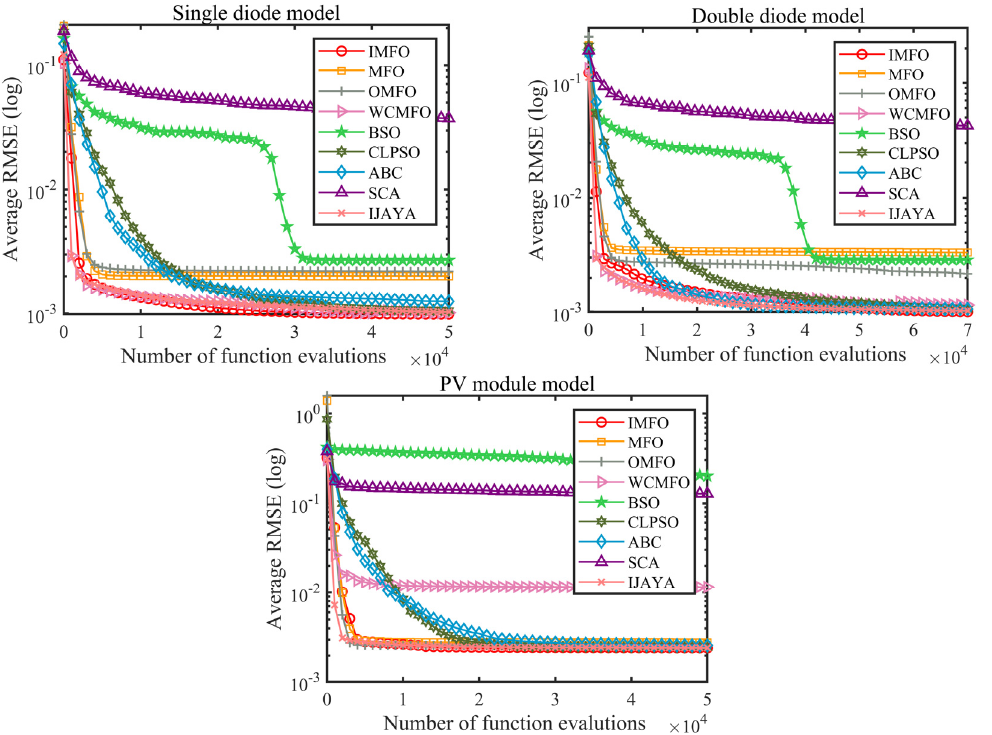
Figure 4. Convergence curves of different algorithms for three models.